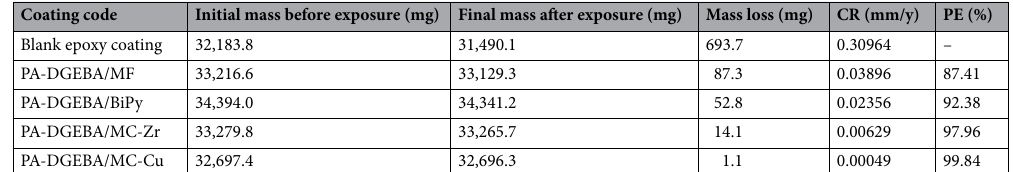
Table 7. Weight loss data of conventional unmodified epoxy and modified MF, Bipy, Zr(IV), and Cu(II) epoxy coated films after 500 h exposure in salt spray cabinet using 5% NaCl solution. CR corrosion rate, PE protection